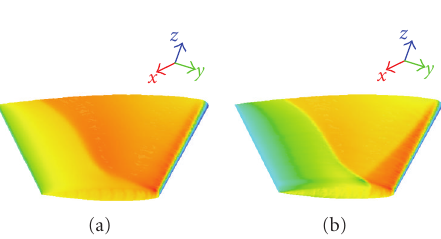
Figure 25: First- and second-order solutions ( M ∞ ) of the ONERA M6 wing mesh—(a) initial solution first-order, (b) restarted solution second-orders.